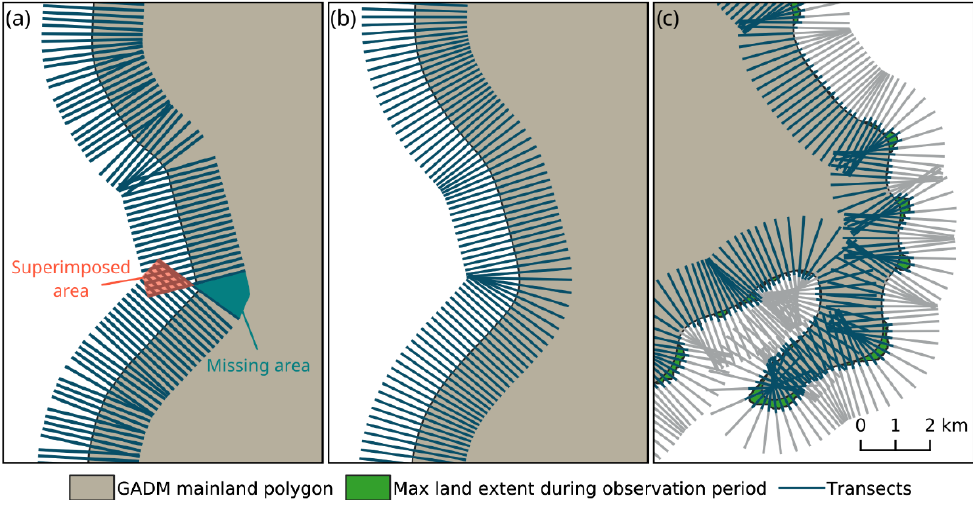
Figure 5. Shore-normal transect generation method. ( a ) Transects generated at original GADM land polygon with 200 m spacing and 3 km length, resulting in superimposed and missing areas at hard edges. ( b ) Transects generated at smoothed GADM land polygon. ( c ) Transects clipped to the maximum observed land area through the entire time series from 1986 to 2021 (blue); unclipped transects (grey).